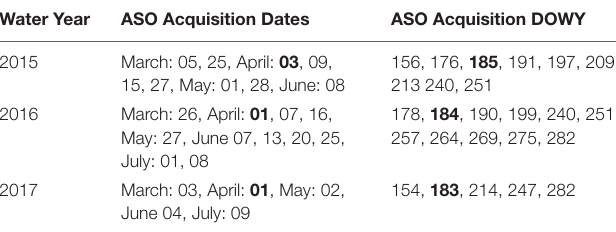
TABLE 2 | Airborne Snow Observatory (ASO) acquisition dates over Tuolumne River watershed and their corresponding day of water year (DOWY)